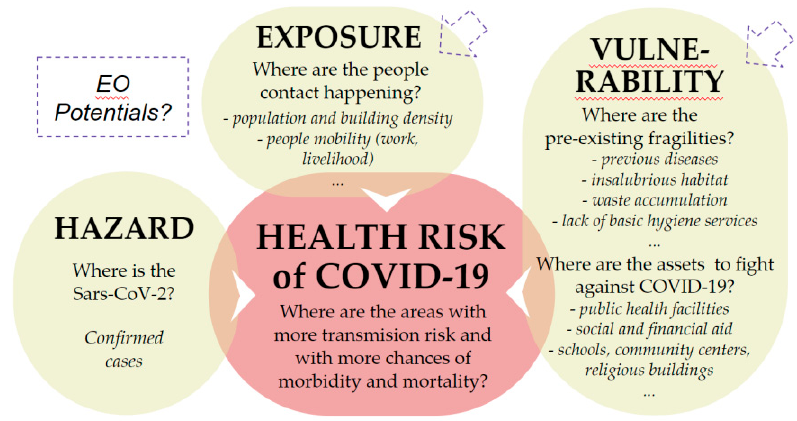
Figure 1. Conceptualization of COVID-19 risks and the role of Earth observation (EO)-based data (based on [17,29]).